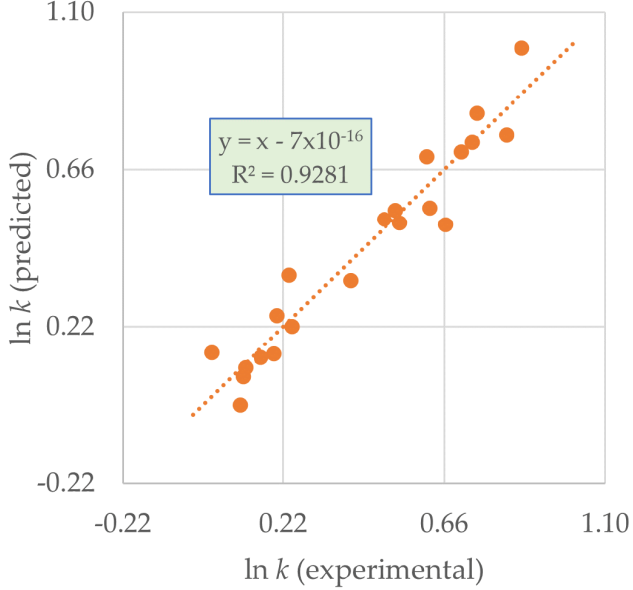
Figure 4. Predicted vs. experimental ln k for Equation